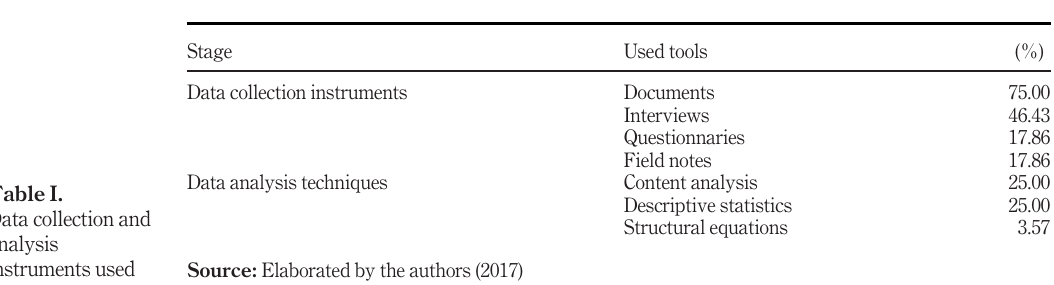
Table I. Data collection and analysis instruments used